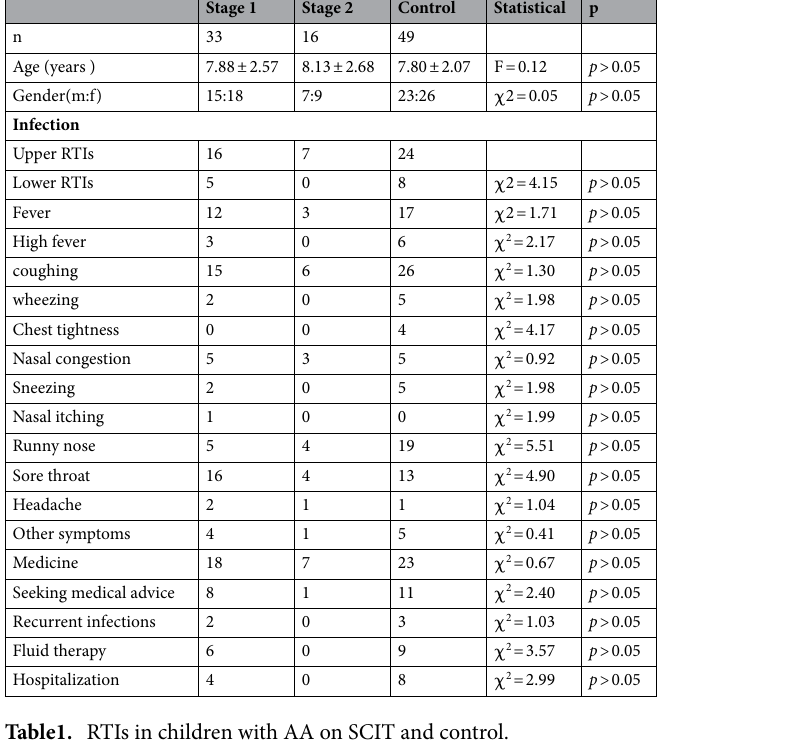
Table1. RTIs in children with AA on SCIT and